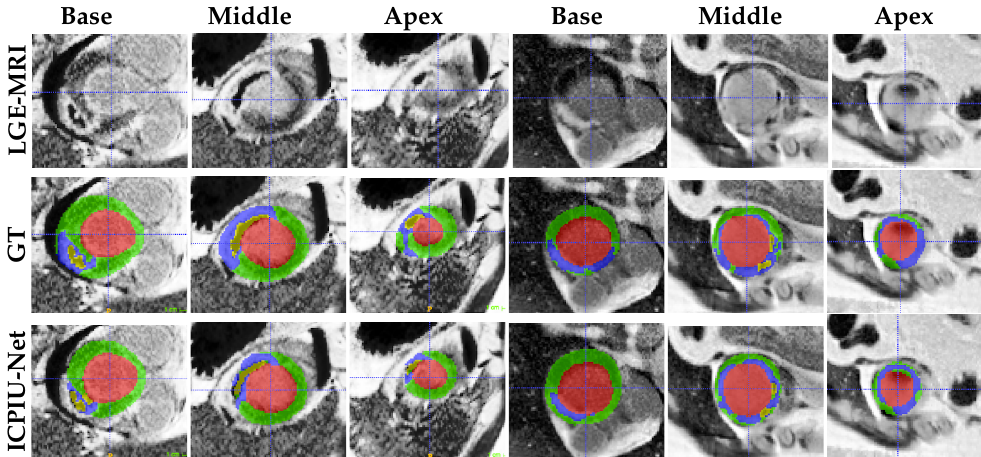
Figure 7. Examples of test segmentation results and ground-truth for three different levels (base, middle, and apex) of two patient slices (columns 1–3 from patient 1 and columns 4–6 from patient 2). Red: LV cavity, Green: LV myocardium, Blue: Infarct, and Yellow: